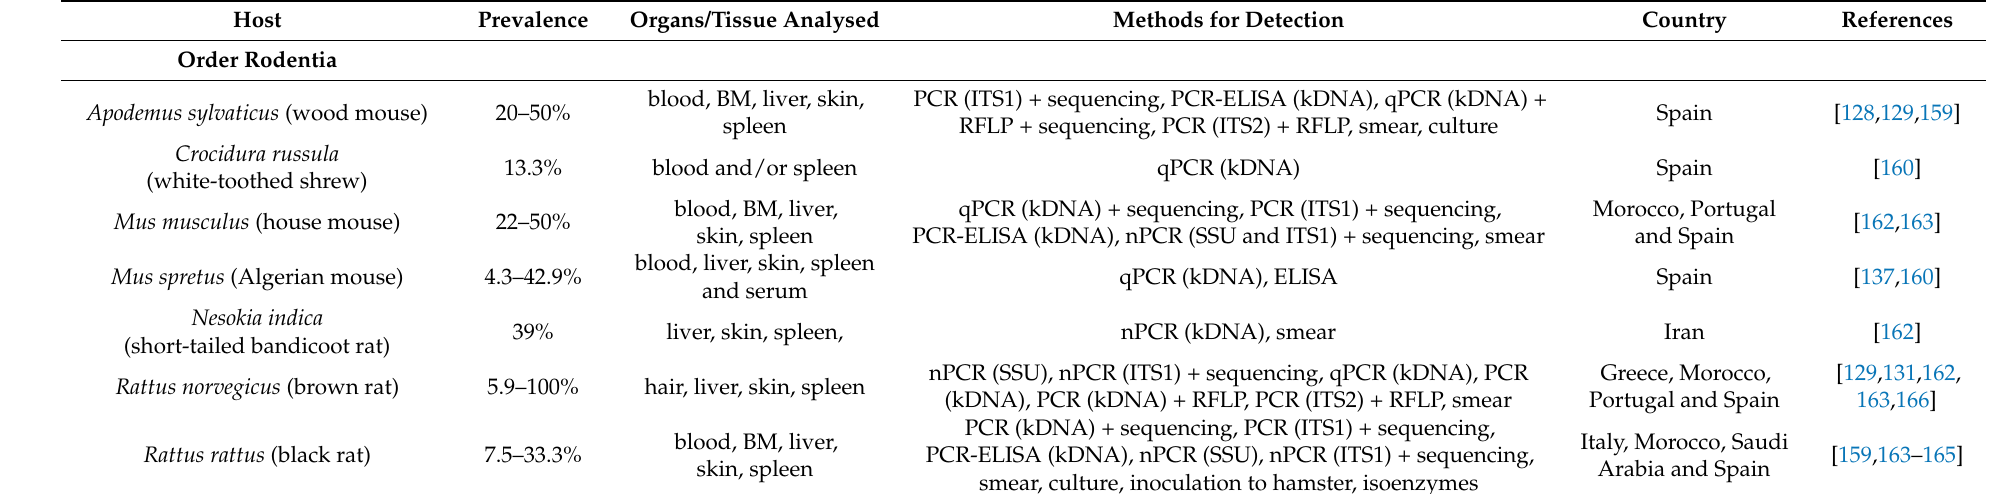
BM: bone marrow; Cyt b: cytochrome B; DFA: direct fluorescence antibody assay; GADPH: glyceraldehyde phosphate dehydrogenase; IC: immunochromatography; ELISA: enzyme immune assay; IFAT: immunofluorescence assay; ITS: internal transcriber spacer; kDNA: kinetoplast DNA; LN: lymph node; nPCR: nested PCR; qPCR: quantitative PCR; RFLP: restriction fragment length polymorphism; SSU: small subunit of ribosomal RNA; WB: Western